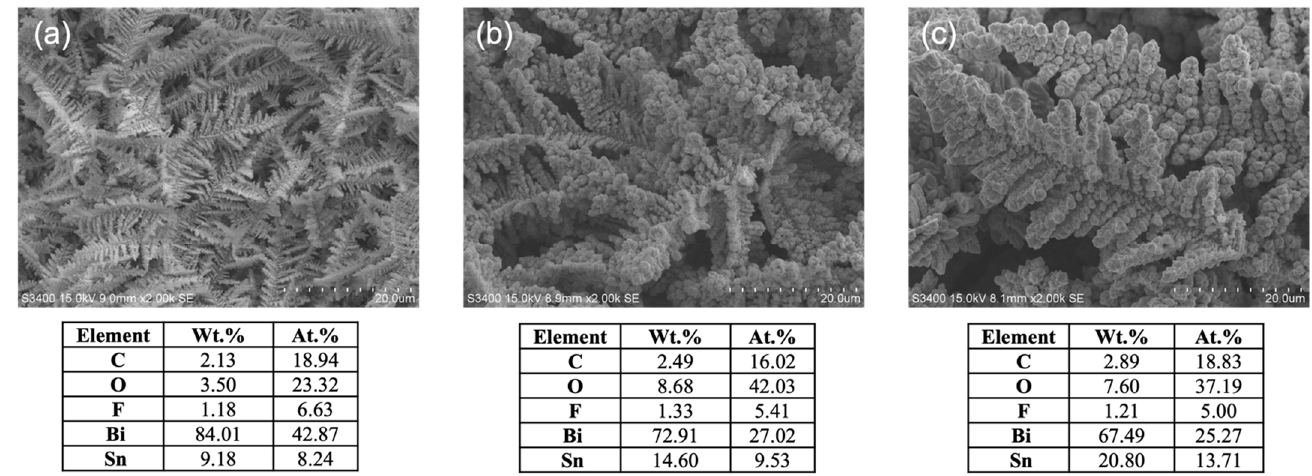
Figure 1 . SEM-EDX results of ( a ) 0.01Bi/Sn, ( b ) 0.05Bi/Sn, and ( c ) 0.1Bi/Sn electrodes .